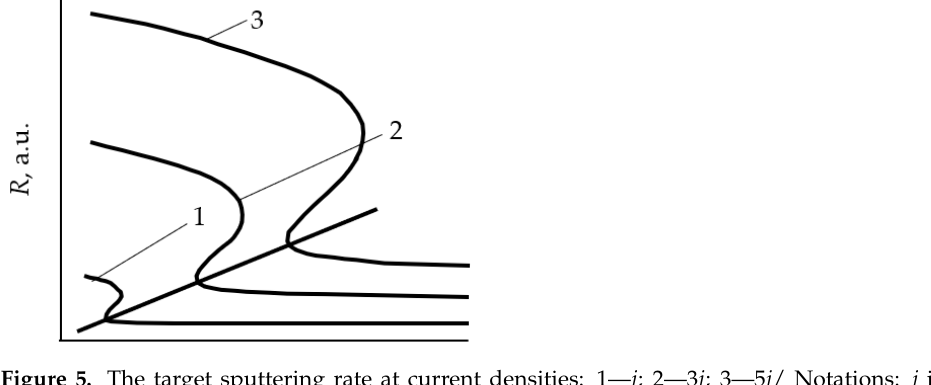
Figure 7. The fl uxes on the substrate surface. Notations: J sM 1 is the fl ux density of metal atoms M 1 ; J sM 2 is the fl ux density of metal atoms M 2 ; J sC 1 is the fl ux density of M 1 X molecules; J sC 2 is the fl ux density of M 2 X molecules; θ sM 1 is the fraction of the substrate surface covered by the metal fi lm M 1 ; θ sM 2 is the fraction of the substrate surface covered by the metal fi lm M 2 ; θ sC 1 is the fraction of the substrate surface covered by the compound fi lm M 1 X; θ sC 2 is the fraction of the substrate surface covered by the compound fi lm M 2 X. In the second process, the co-spu tt ering of two targets made from di ff erent metals was studied. The physical model of this process is illustrated in Figure 8. The targets of metals M 1 , M 2 are spu tt ered in the mixture of Ar + X 2 . As in all previous cases, the processes of formation and spu tt ering of compound fi lms compete on their surfaces. The processes occurring on the targets are not related; therefore, in the steady state, two equations arise with two independent variables: